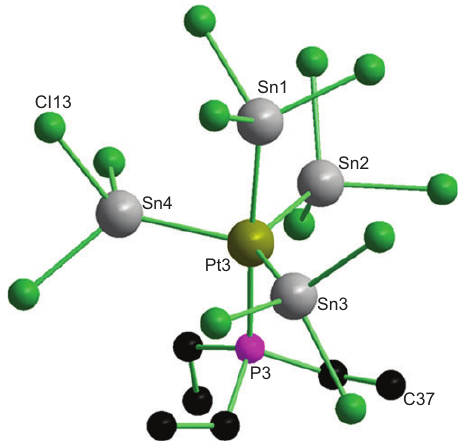
Figure 3 Structure of [(PEt groups are omitted for